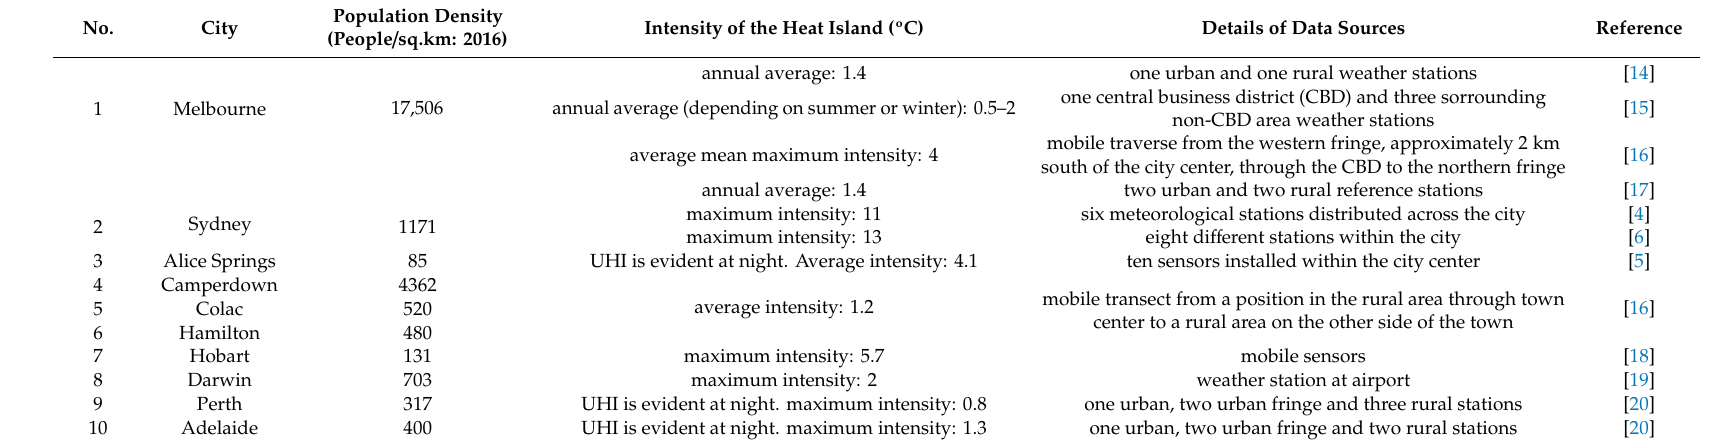
Table 1. The intensity of the urban heat island (UHI) e ff ect in Australian cities and